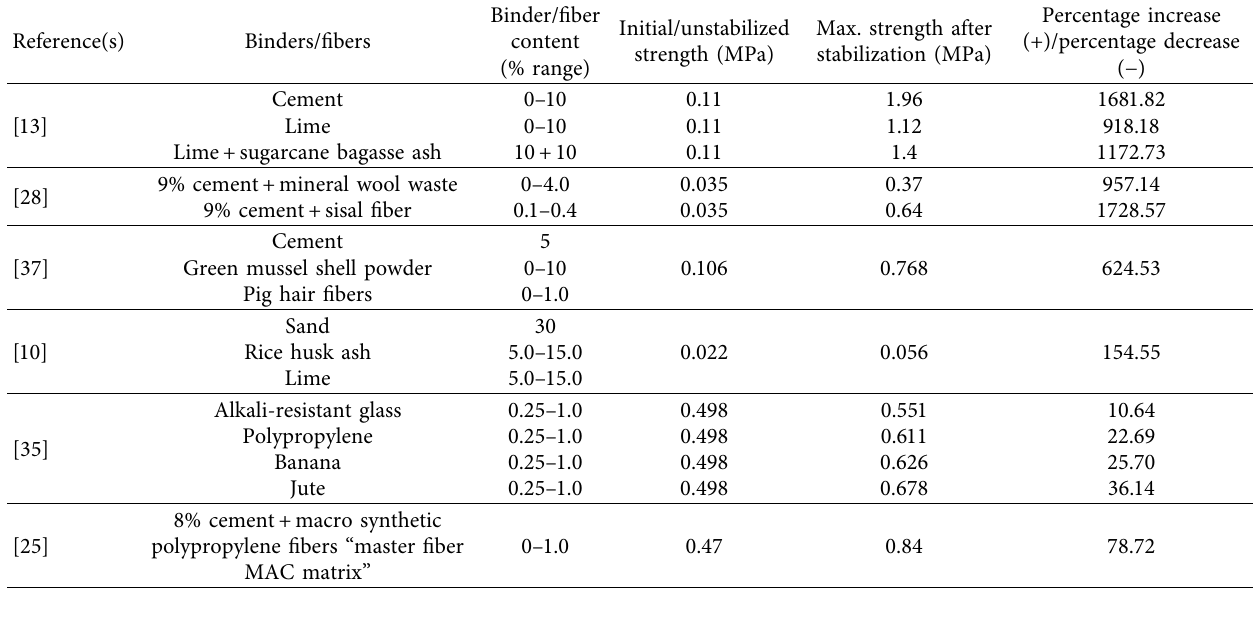
Table 14: Flexural strength of unfired admixed soil blocks as reported in the reviewed articles. Reference(s)